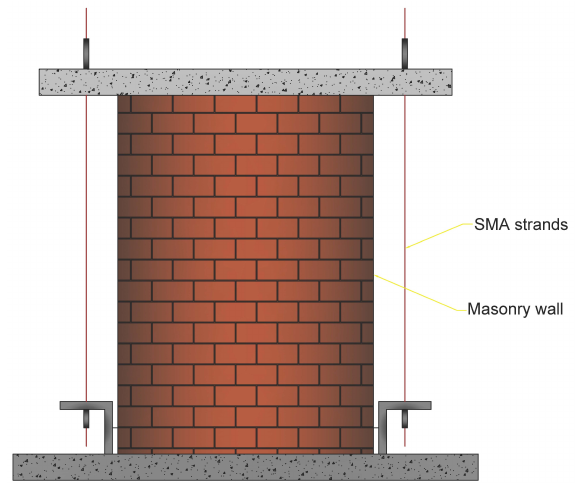
Figure 10. The schematic of the proposed system with SMA wire for connection ties